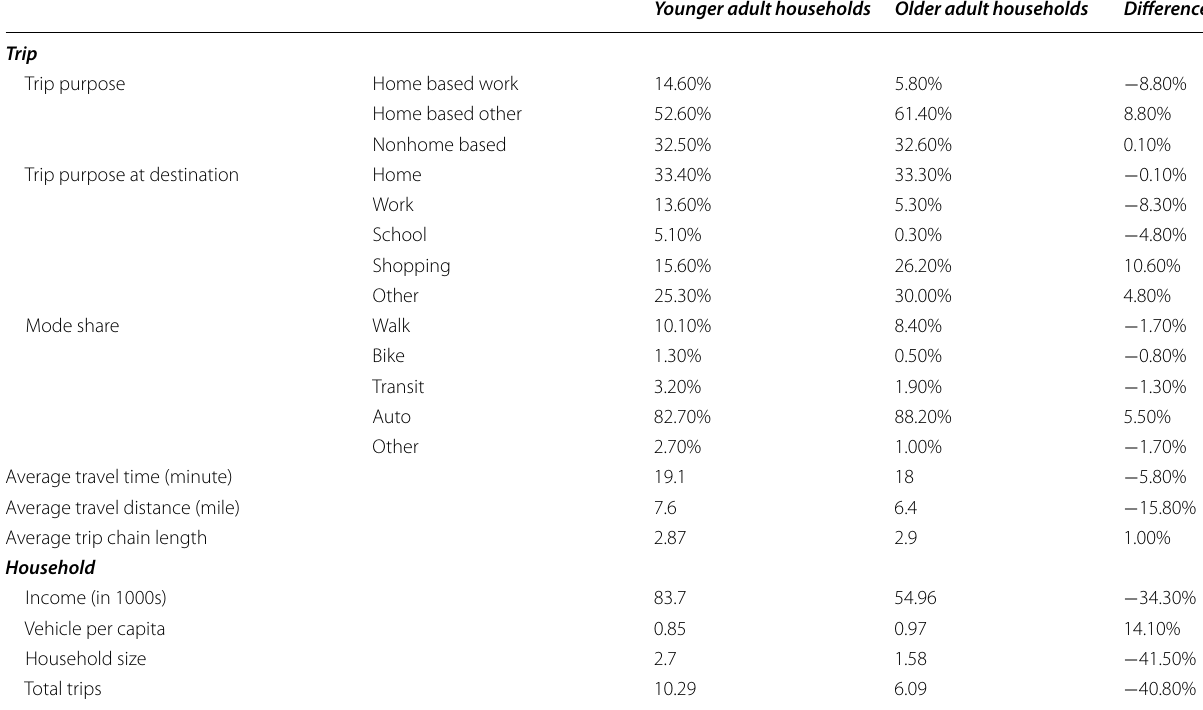
Table 4 Younger adults vs. older